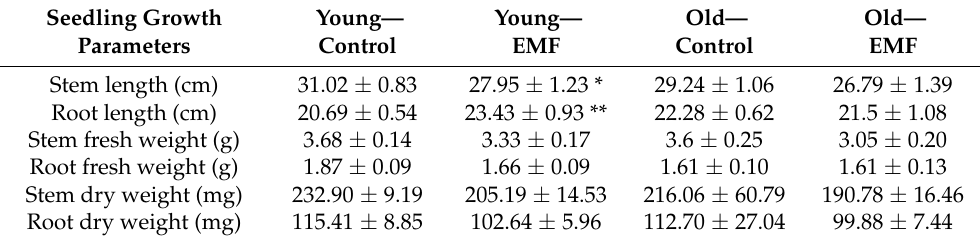
Table 5. The effects of EMF on growth parameters of field bean seedlings cultivated for 14 days in pots under long-day